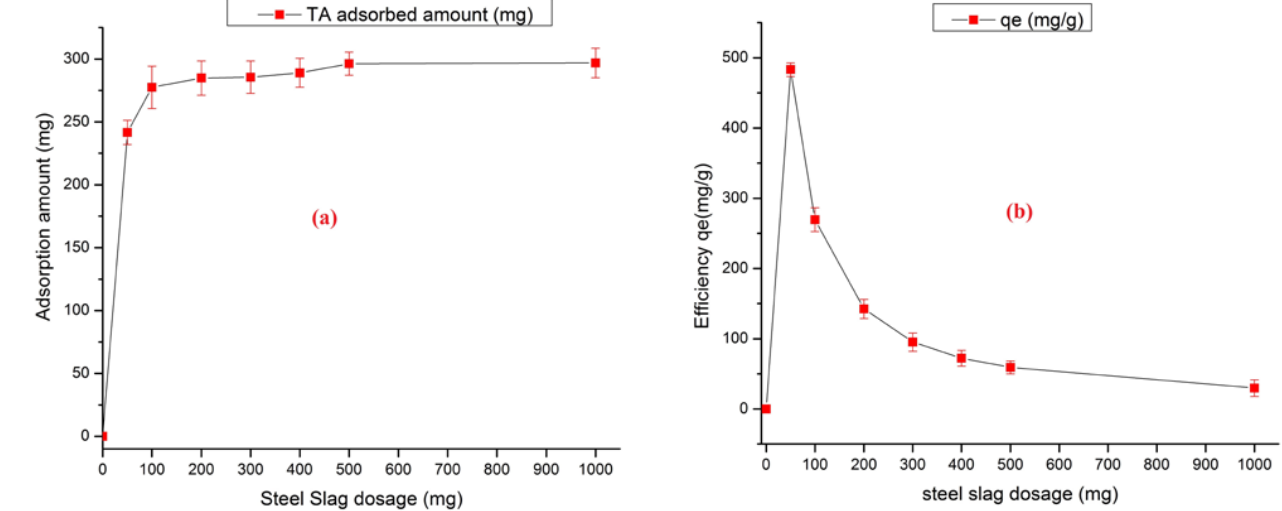
Figure 8. Effect of SS dosage on TA adsorbed amount ( a ) and efficiency of removal ( b ). Adsorption conditions: pH = 6.6; T = 293 K; time = 225 min; initial concentration = 300 mg/L, volume = 100 mL.